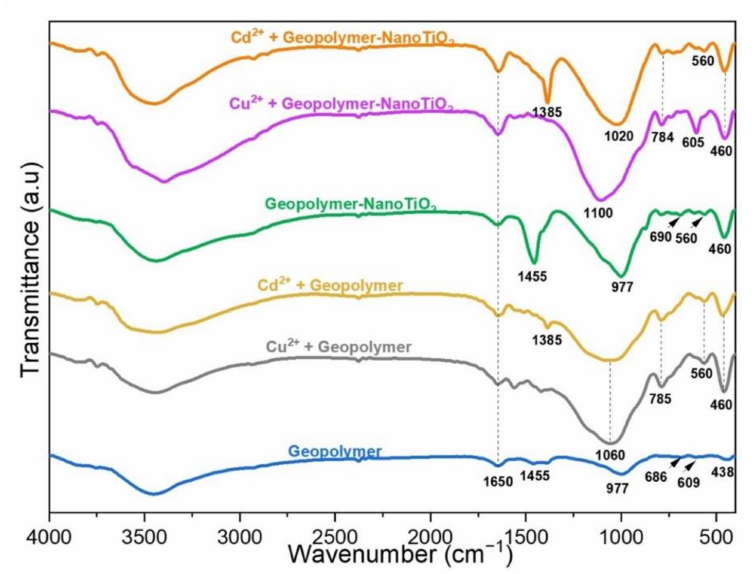
Figure 9. FTIR spectra of geopolymer and geopolymer-NanoTiO 2 after adsorption (experimental